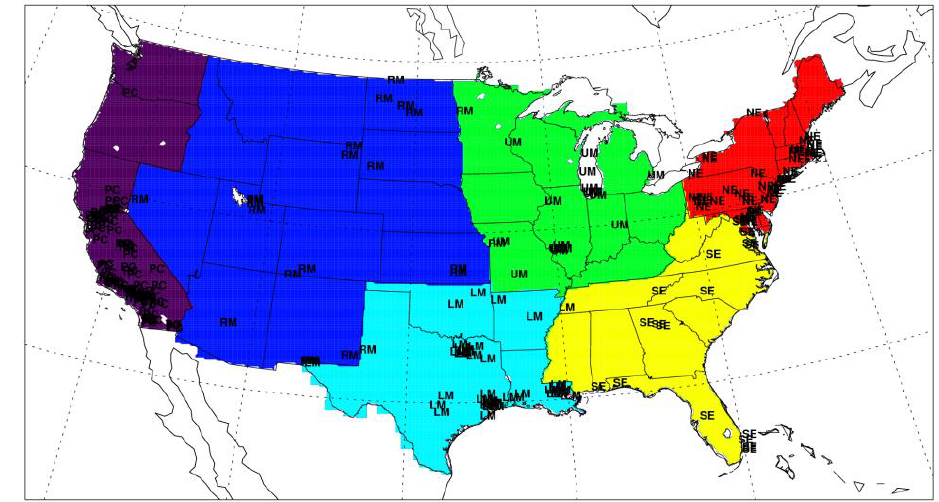
Fig. 1. Map of the six geological regions of the US, Pacific Coast (PC), Rocky Mountains (RM), Lower Middle (LM), Upper Middle (UM), South East (SE), and Northeast (NE) for the performance evaluation (different colors represent six geological regions and letters locate EPA AQS stations of NO x